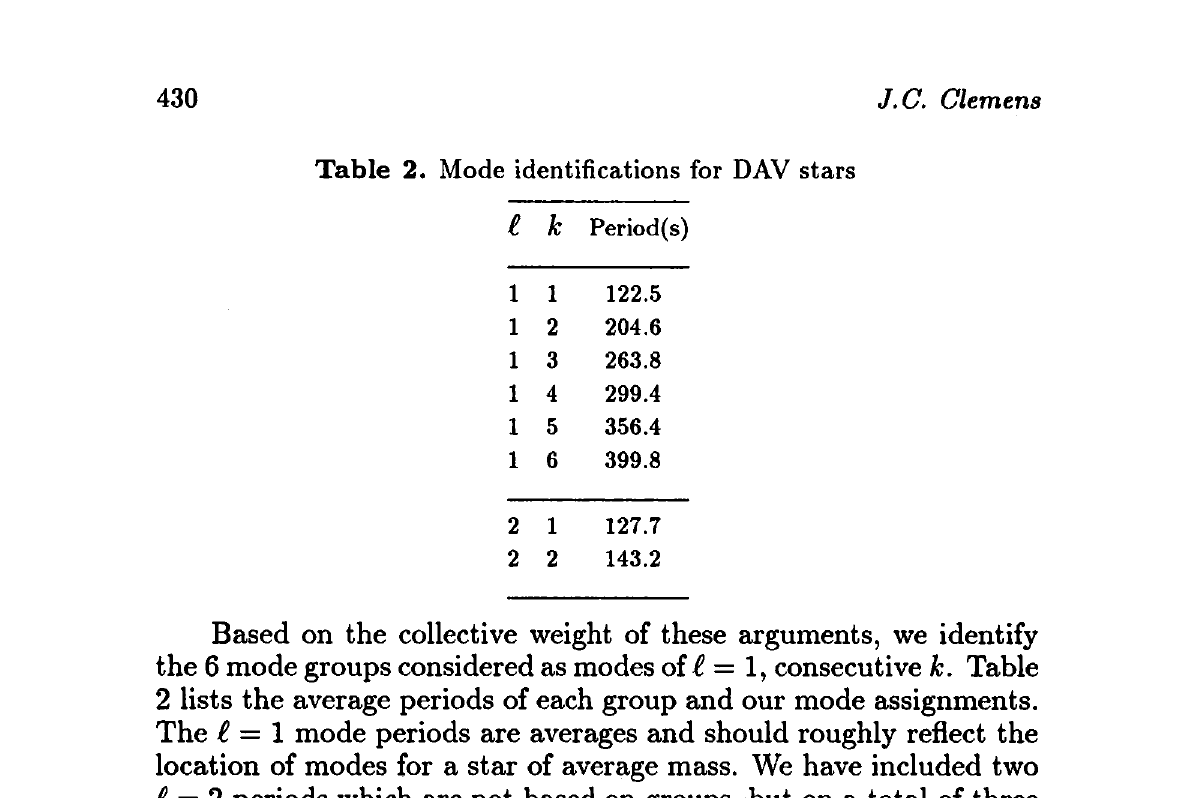
Table 2. Mode identifications for DAY